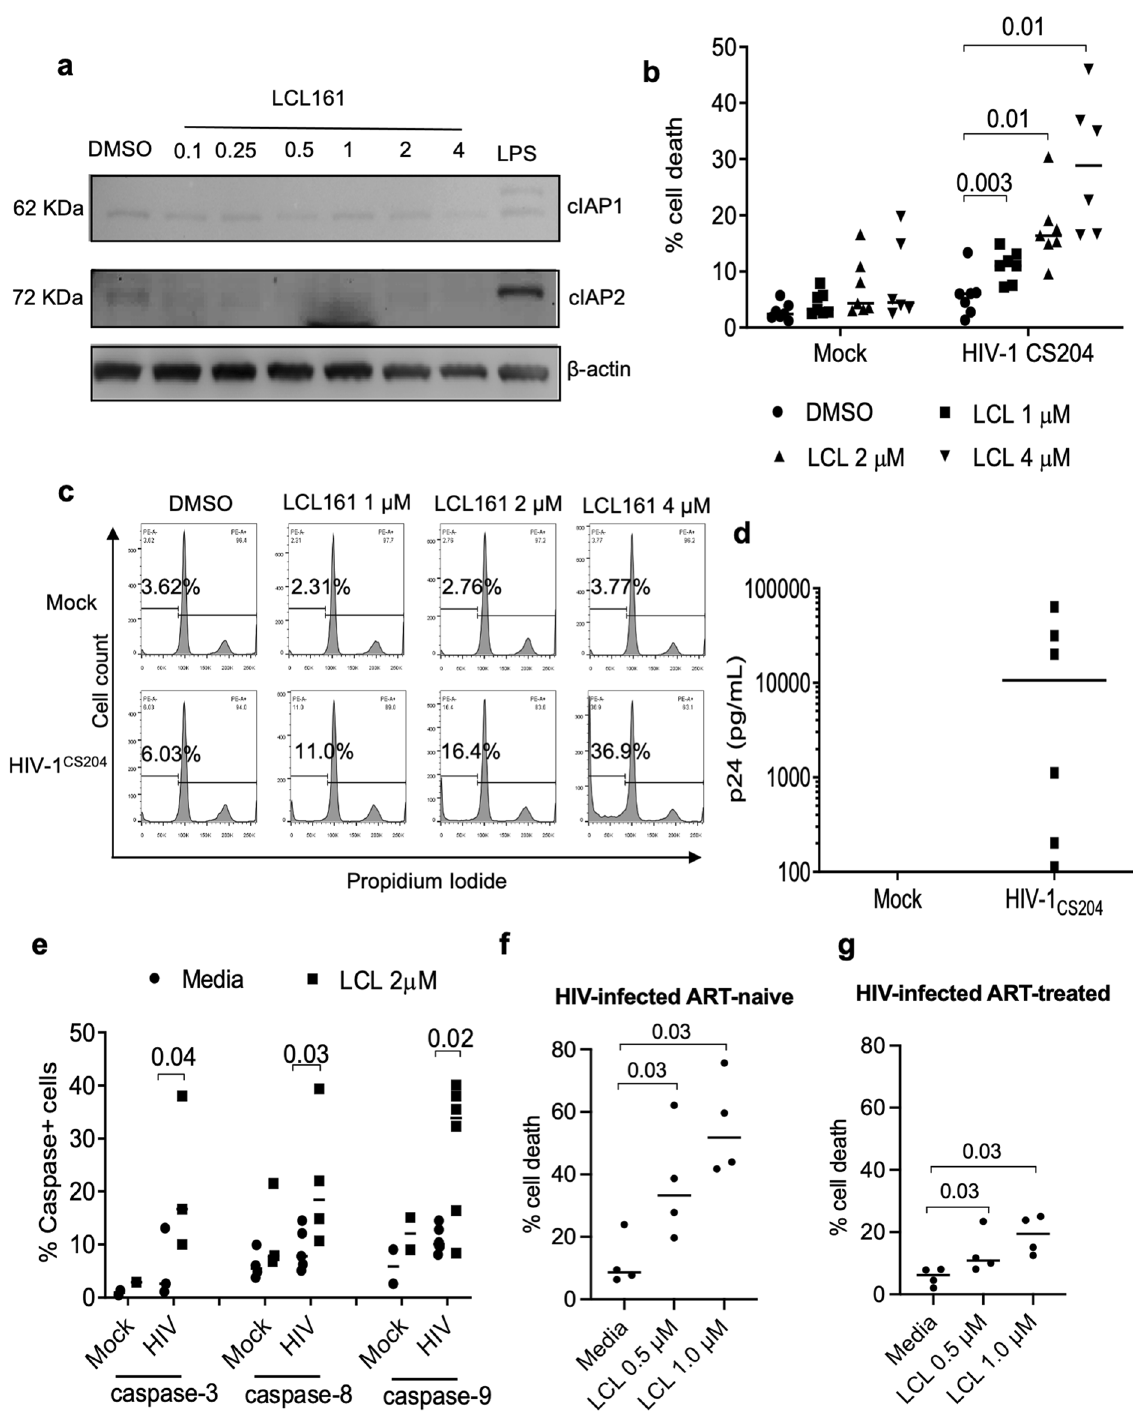
Figure 2. SM induces cell death of HIV-infected MDMs ( a ). MDMs were treated with increasing concentration of LCL161 for 48 h and cytosolic fractions were collected. 30 µg of total proteins were subjected to western immunoblotting to probe for cIAP1 and cIAP2. ( b ) Human MDMs were in vitro infected with HIV-1 CS204 (100 ng p24/well) for 7 days (n = 4). The cells were then treated with LCL161 for 48 h and cell death was assessed by PI staining and flow cytometry. The representative histograms are shown in ( c ). ( d ) After 7 days of infection, supernatants were analyzed for p24 by ELISA (n = 6). ( e ) Mock and HIV-infected MDMs treated with SM for 48 h and caspase-3 (n = 3), -8 (n = 4), and -9 (n = 6) positive cells were analyzed by flow cytometry. MDMs generated from naïve ( f ) and ART-treated ( g ) HIV-individuals were treated with LCL161 for 48 h. Cell death was assessed by PI staining and flow cytometry. The p -values were calculated using two-tailed Mann–Whitney U test. The uncropped western blot images are in Supplementary Fig. 7. The densitometric readings for figure ( a ) are shown in Supplementary Fig.